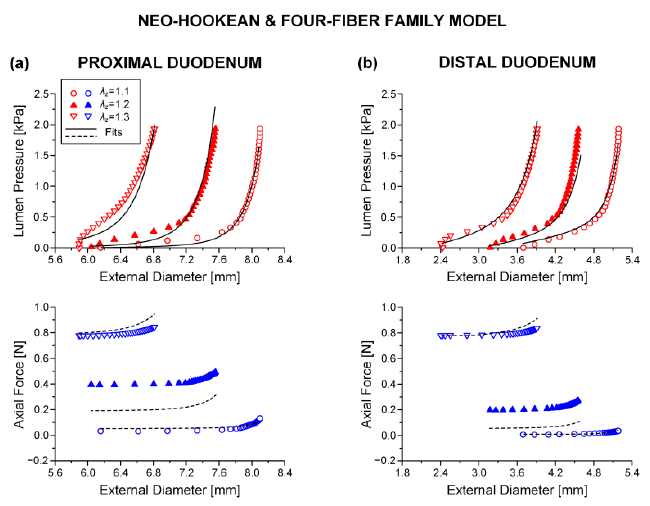
Figure 2. Plot of measured lumen pressure (red color) and axial force (blue color) vs. external diameter data at three different fixed axial stretches 𝜆 𝑧 = {1.1, 1.2, 1.3} for a characteristic specimen from the proximal and distal duodenum and fits (solid lines for lumen pressure and dashed lines for axial force) calculated using the neo-Hookean and four-fiber family microstructure-based model of Equation (1) with the following best-fit model parameters for the ( a ) proximal duodenum: 𝜇 = 3.7 × 10 −11 kPa, 𝑘 1𝑑 = 0.312 kPa, 𝑘 2𝑑 = 16.078, 𝑘 1𝑎 = 8.467 kPa, 𝑘 2𝑎 = 3.143, 𝑘 1𝑐 = 9.5 × 10 −9 kPa, 𝑘 2𝑐 = 3.922, 𝑎 0 = 0.670 rad, ε = 0.321, 𝑅 2 = 0.870, 𝑑𝑒𝑡(𝐑) = 4.7 × 10 −5 and ( b ) distal duodenum: 𝜇 = 5.0 × 10 −6 kPa, 𝑘 1𝑑 = 0.336 kPa, 𝑘 2𝑑 = 6.940, 𝑘 1𝑎 = 2.470 kPa, 𝑘 2𝑎 = 7.840, 𝑘 1𝑐 = 0.127 kPa, 𝑘 2𝑐 = 3.4 × 10 −8 , 𝑎 0 = 0.308 rad, ε = 0.322, 𝑅 2 = 0.881, 𝑑𝑒𝑡(𝐑) = 6.3 × 10 −6 . Data are shown every 0.5 mmHg for clarity.